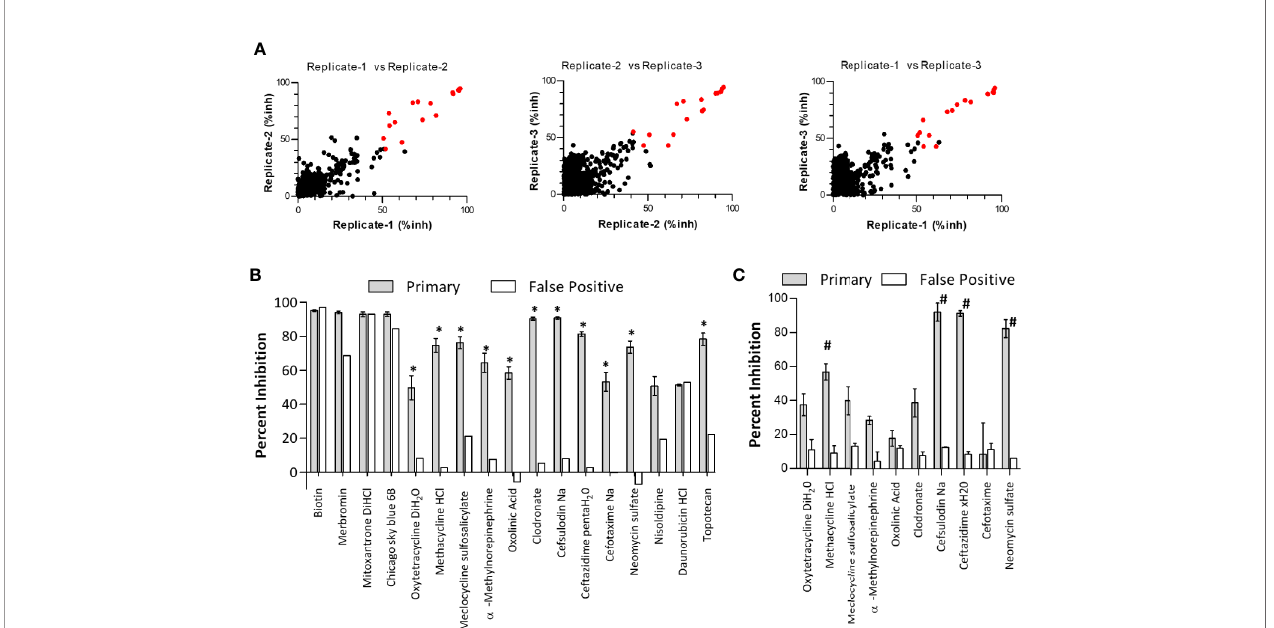
FIGURE 2 | Veri fi cation of primary screen “ Hit ” speci fi city and activity. (A) Primary high throughput screening hits. The primary screen of the Prestwick Compound Collection was performed in triplicate, and scatter plots of combinations of replicates are shown. Negative inhibition was omitted from the plots. Primary hits were identi fi ed as compounds with an average of ≥ 50% inhibition from all three replicates (highlighted as red data points). inh, inhibition. (B) From the primary screen, compounds were considered hits if they demonstrated an average inhibition of ≥ 50% at 30 uM, and a greater than 3-fold difference in activity between the primary screen (gray bars) and the false-positive screen (white bars). Asterisks (*) designate hits carried forward. Data are expressed as the mean percent inhibition ± SEM from three screening runs (note that the secondary false-positive screen was run only once). (C) Hits (identi fi ed by asterisks in panel B) were reordered from different commercial vendors to verify compound activity by retesting in the primary and false-positive screens at 30 uM. Note that topotecan was not retested due to a lack of solubility. Data are expressed as the mean percent inhibition ± SEM from three experiments (note that ceftazidime xH20 and cefotaxime false-positive screens were performed only twice). # denotes compounds ful fi lling the original hit